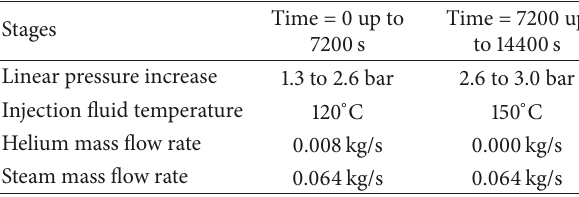
Table 1: Initial and boundary